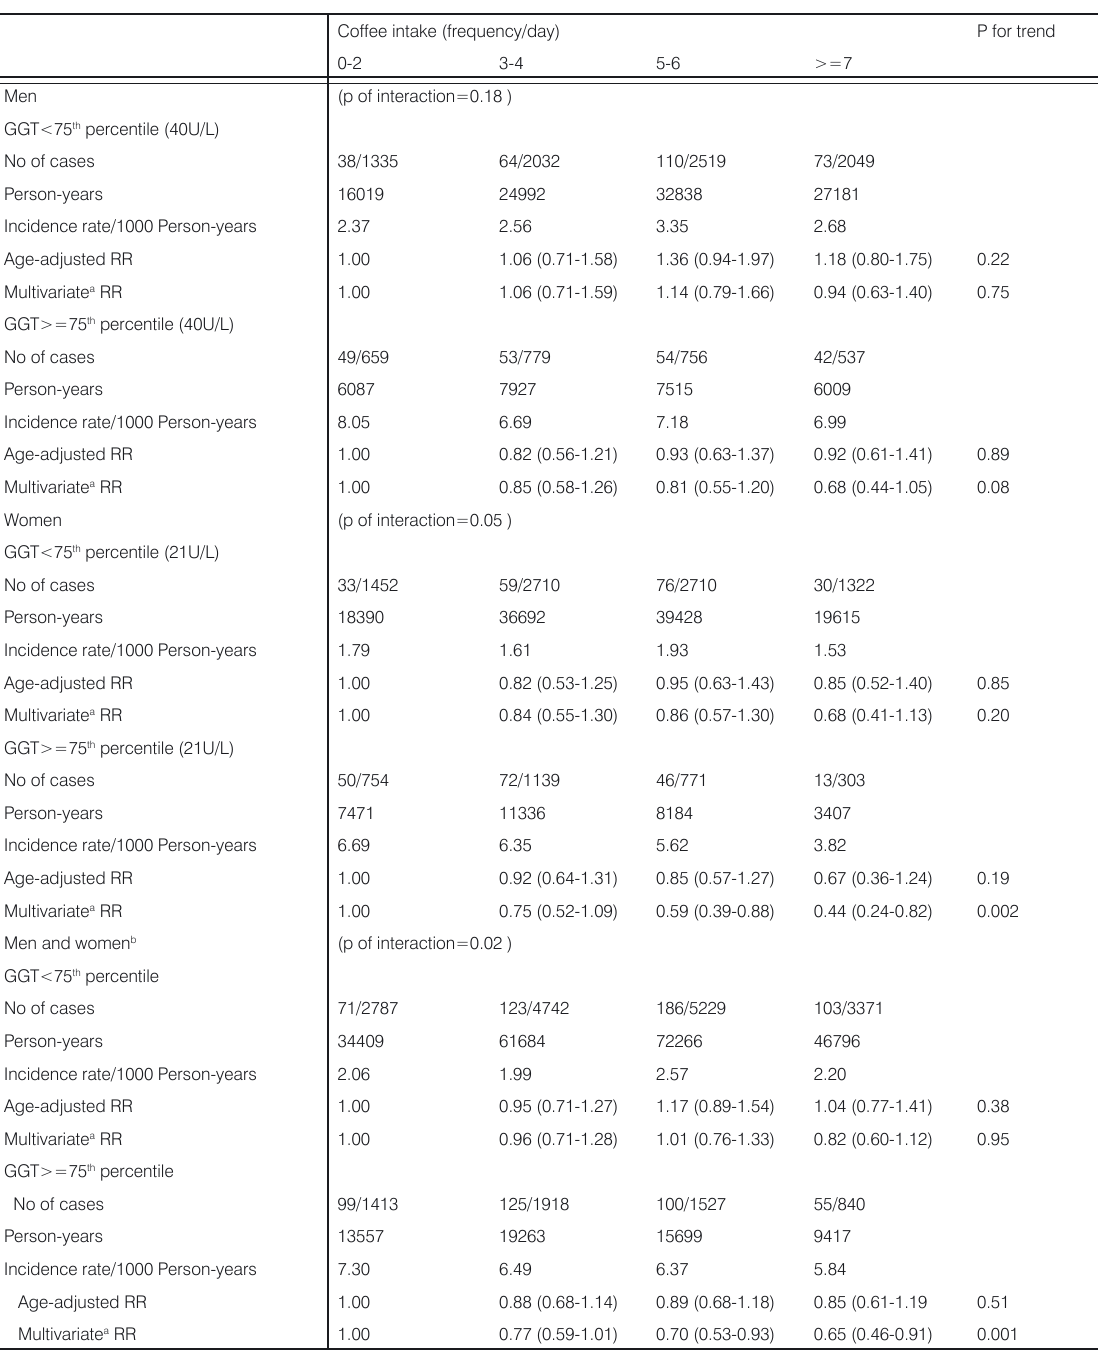
Table 5. Relationship between coffee consumption and incident diabetes stratified by baseline g-glutamyltransferase level [69